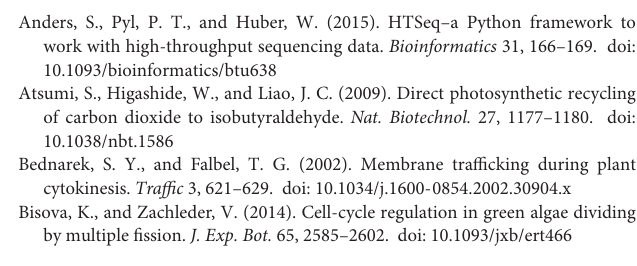
Supplementary Figure 1 | Alignment of LOG proteins from different seed and non-seed plants. Supplementary Figure 2 | Conserved domains of LOG proteins from non-seed and seed plants. Supplementary Figure 3 | SDS-PAGE of purified CvarLOG1 recombinant protein. Supplementary Figure 4 | Wild type growth curve from 1 to 29 dpi (Optical Density at 750 nm). Supplementary Figure 5 | Photograph of 45 dpi old culture of LOG OX1 versus wild type. Supplementary Table 1 | Accessions of LOG proteins from different seed and non-seed plants used for phylogenetic analysis. Supplementary Table 2 | List of differentially expressed genes in LOG OX1 versus wild type by RNA-Seq, 1.5-fold change, adjusted p -value ( q -values) ≤ 0.05. Supplementary Table 3 | Major upregulated pathways in LOG OX1 as determined by RNA-Seq, 1.5-fold change, adjusted p -value ( q -values) ≤ 0.05. Supplementary Table 4 | Major downregulated pathways in LOG OX1 as determined by RNA-Seq, 1.5-fold change, adjusted p -value ( q -values) ≤ 0.05. Supplementary Table 5 | Primers used in this